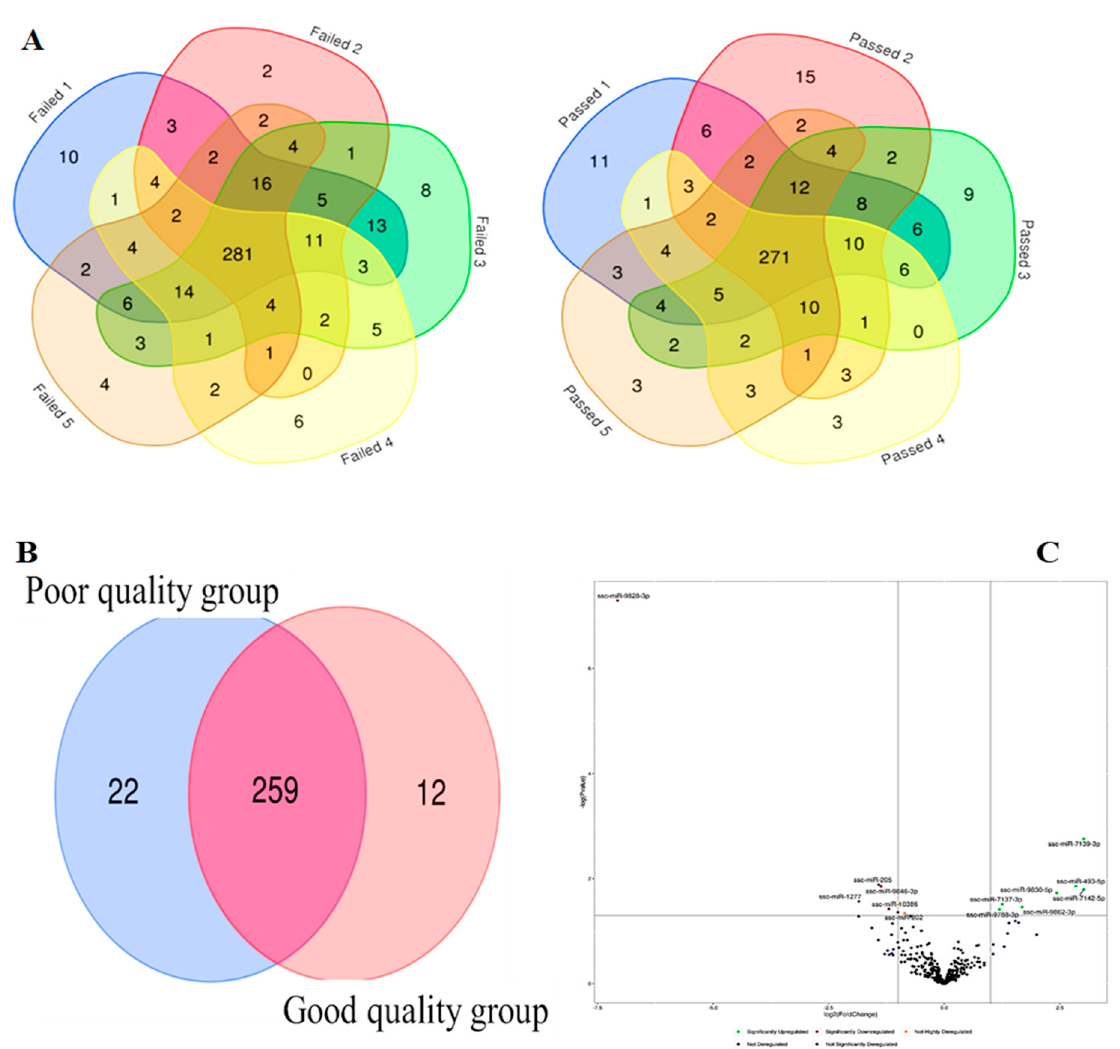
Figure 4. Total detected and differentially expressed miRNAs. Venn diagram represents the totals of 271 and 281 unique miRNAs detected in all replicates (n = 5) of each good (passed) and poor (failed) semen quality group ( A ). Venn diagram comparison of both groups reveals the presence of 88% shared miRNAs ( B ). Volcano plot illustrates differentially expressed miRNAs through fold change deregulation ( ≥ 2 or log2 fold change of ≥ 1 or ≤− 1, with FDR ≤ 0.05 or -log10 FDR of ≥ 1.30103) ( C ). Table 2. List of differentially expressed miRNAs in direction of good semen quality group.